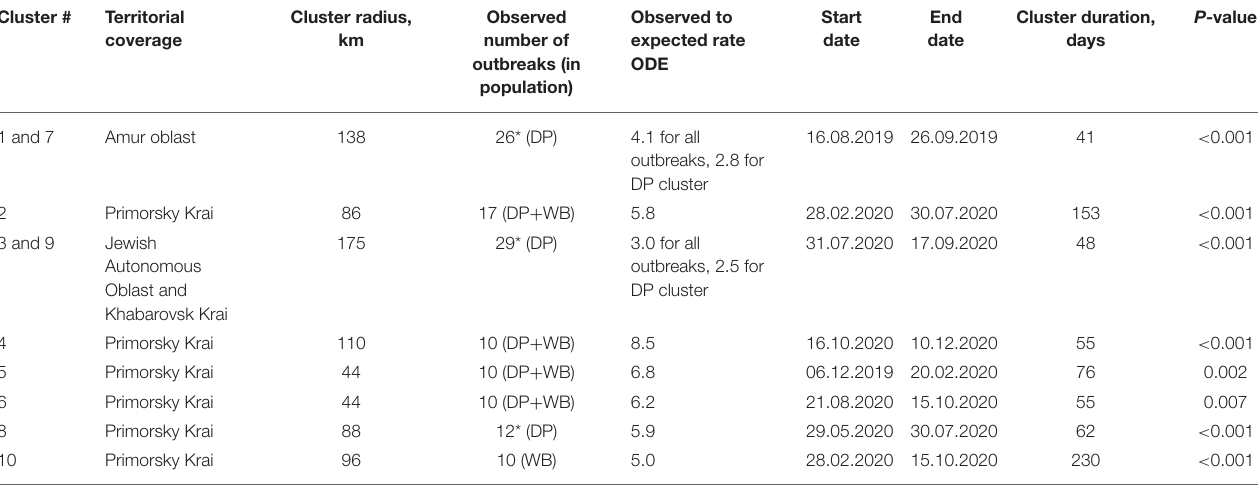
TABLE 1 | Characteristics of spatiotemporal clusters of ASF outbreaks in domestic pigs and wild boar in the Far East of Russia, 2019–2020. Cluster # Territorial coverage